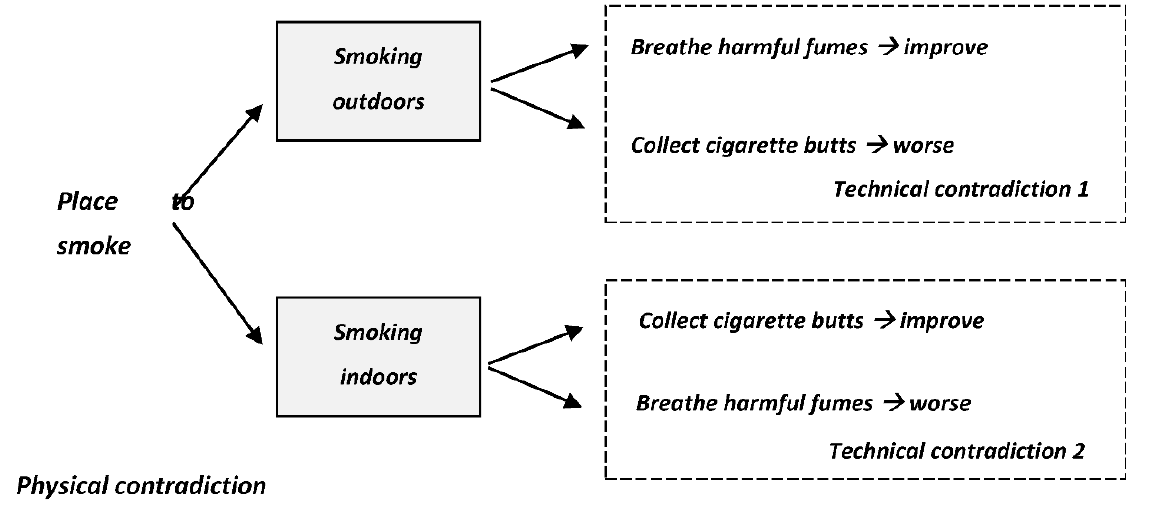
Figure 1. Technical Contradiction.